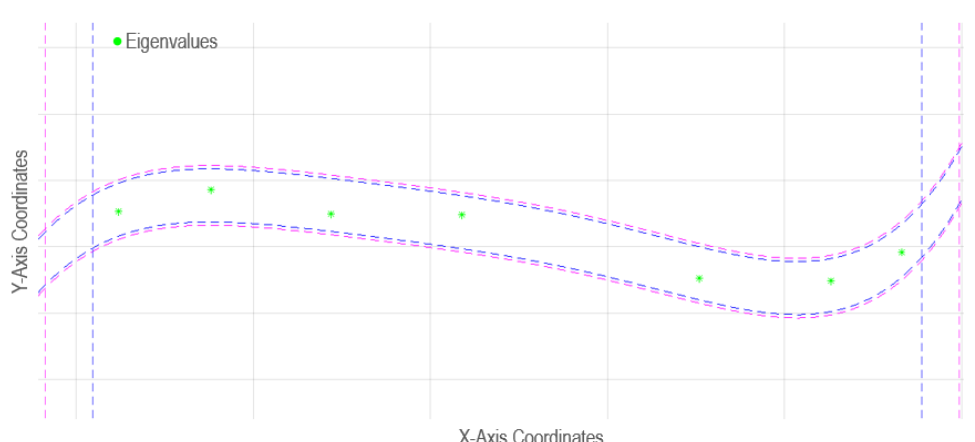
Figure 7. Low EDC cluster.